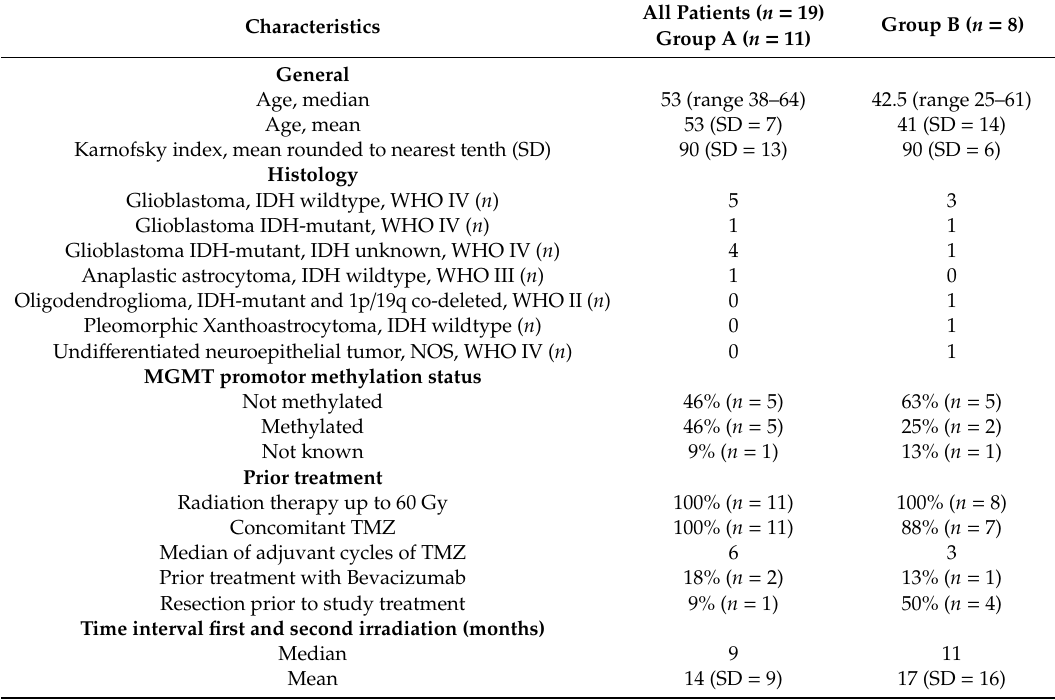
Table 1. Patient characteristics MRS substudy. Decimal round method if not otherwise